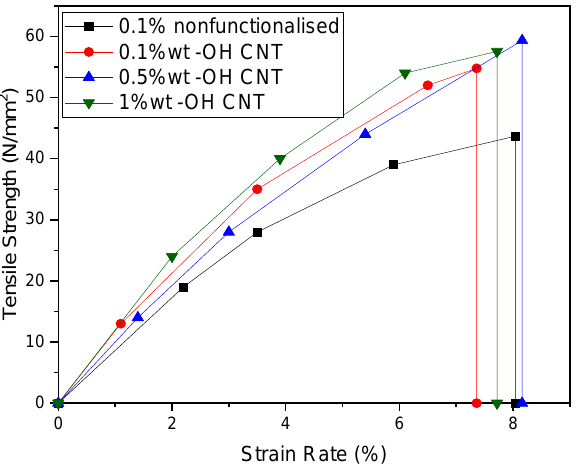
Figure 6. Tensile stress–strain curves for non-functionalized and f-MWCNT nanocomposites.